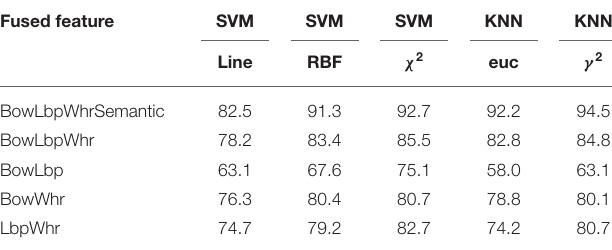
TABLE 5 | The classification result with SVM ( χ 2 ) on sample set B.